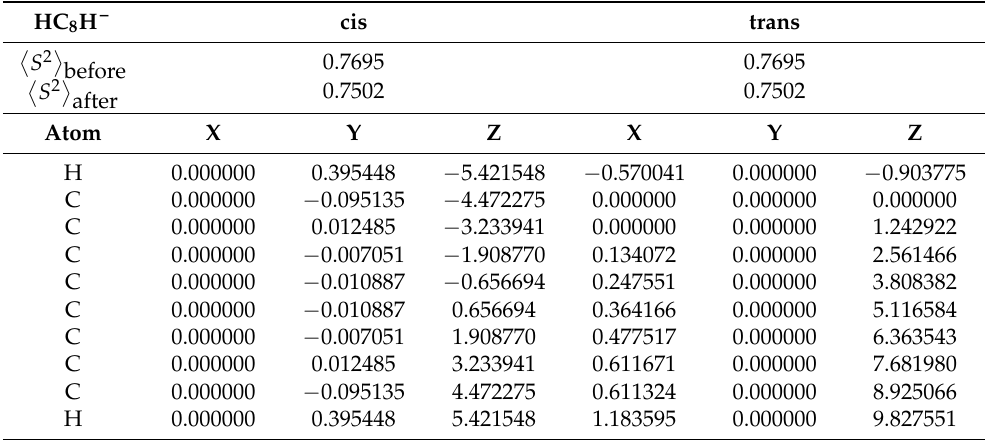
Table A6. Cartesian coordinates in Å of the cis and trans HC 8 H – anion conformers optimized at the UB3LYP/6-311++G(3df,3pd) level of theory. Subscripts “before” and “after” label the values of the total spin before and after annihilation of the first spin contaminant.